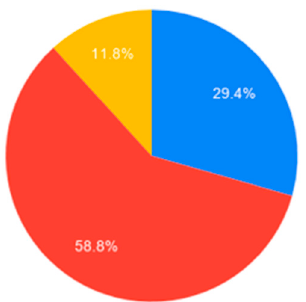
Figure 4. Do you think that these indicators could influence the quality of your production?